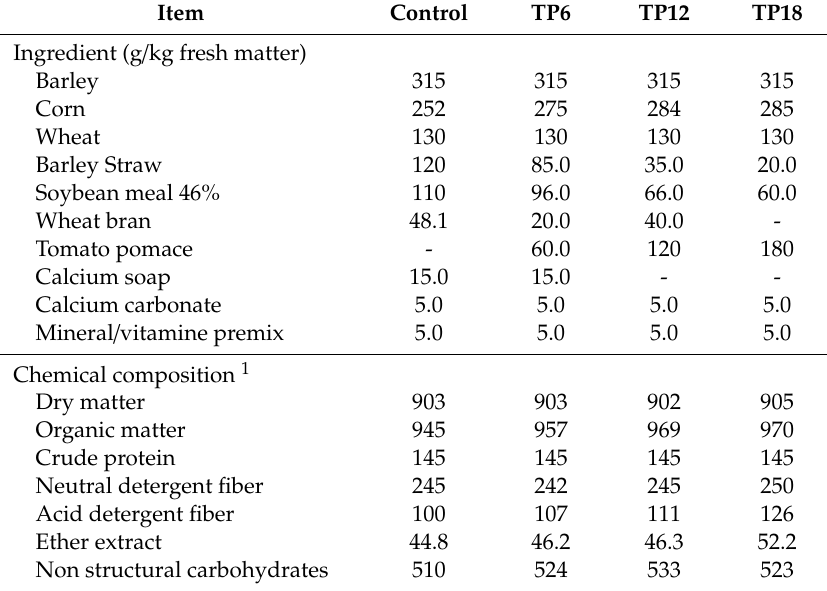
Table 1. Ingredients and chemical composition of experimental diets containing increased amounts of tomato pomace (TP) used in Experiment